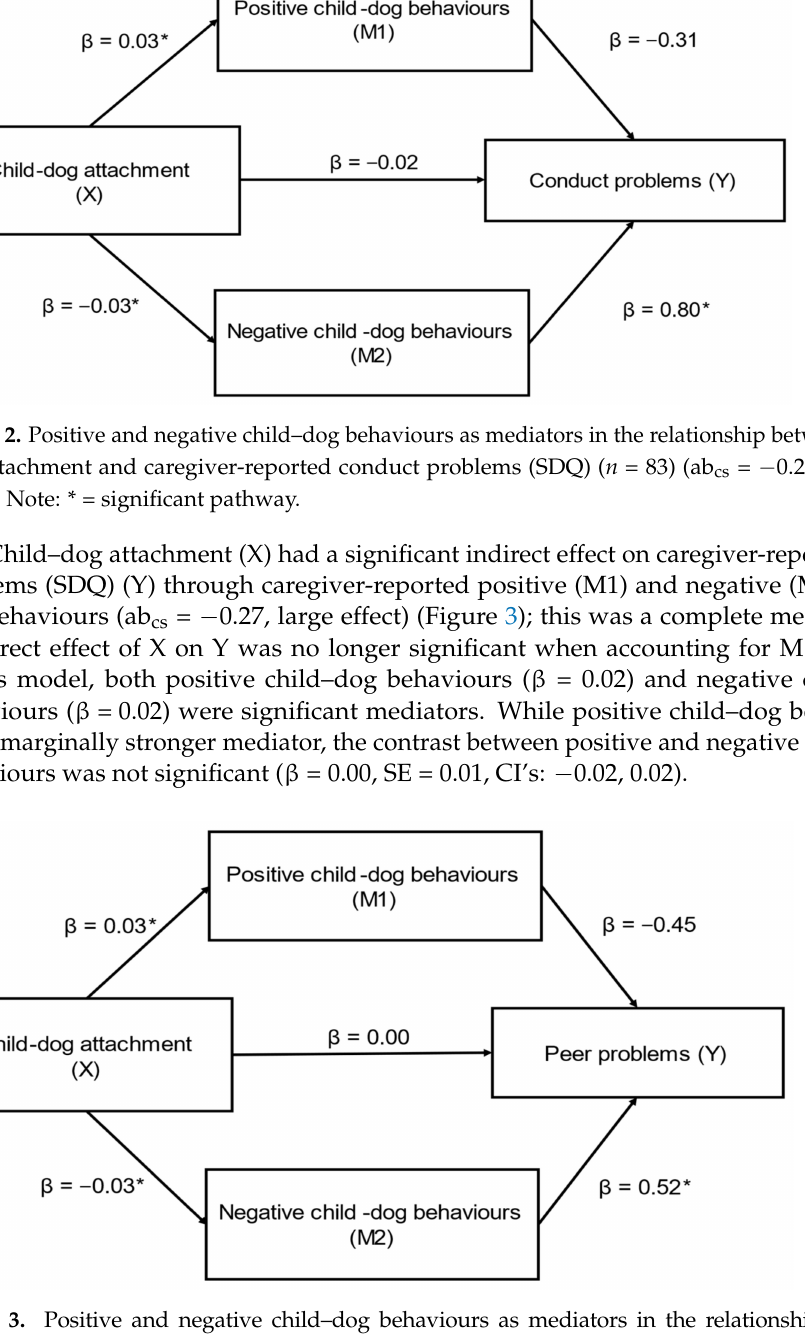
Figure 3. Positive and negative child–dog behaviours as mediators in the relationship between child–dog attachment and peer problems (SDQ) ( n = 83) (ab cs = − 0.27, large effect). Note: * = significant